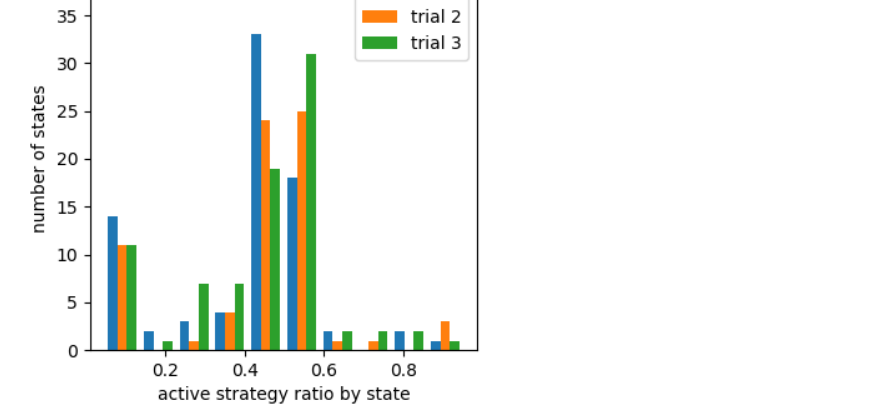
Figure 8. Percentage of active strategies chosen by state (cooperative rewards (0, 0), after passive strategy is